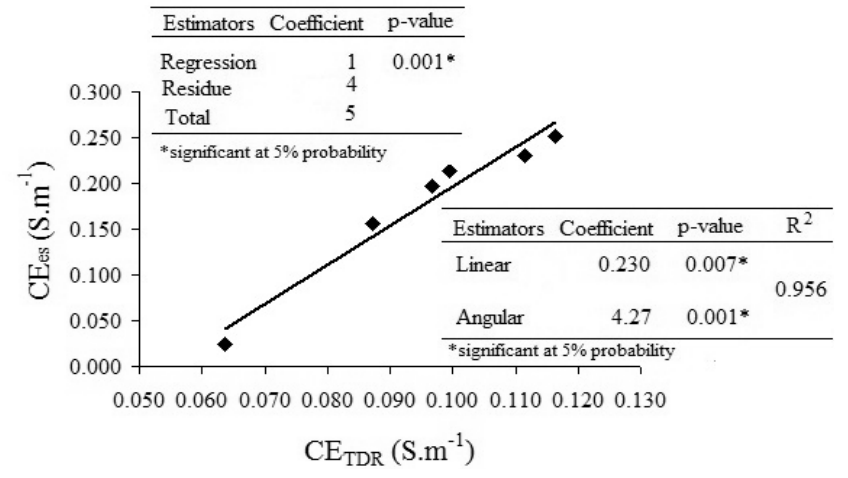
Figure 6. Regression model of the soil electric conductivity by the soil saturated extract method (EC apparent electric conductivity determined by TDR (EC